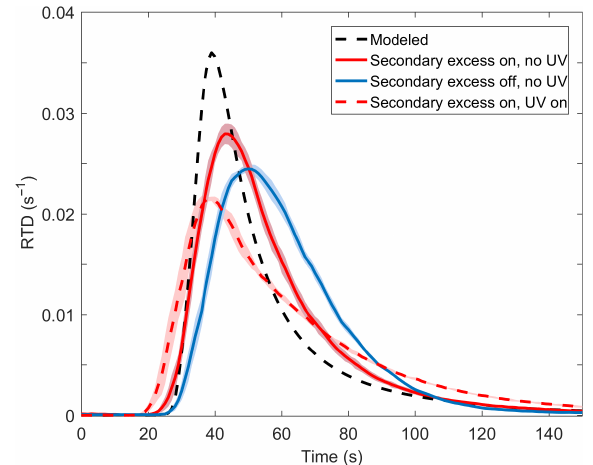
Figure 2. Measured and modeled CO 2 pulses before and after the oxidation reactor. The shaded area shows the standard deviation of three pulses. The CO 2 background of 380ppm is subtracted from the results.